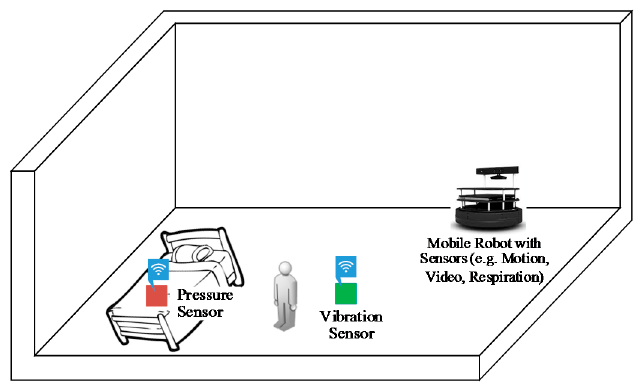
Figure 6. Sample schematic setup for elderly care based on different ambient sensors and a mobile robot. Table 10. Summary of research works that use ambient sensors in mobile robotics.